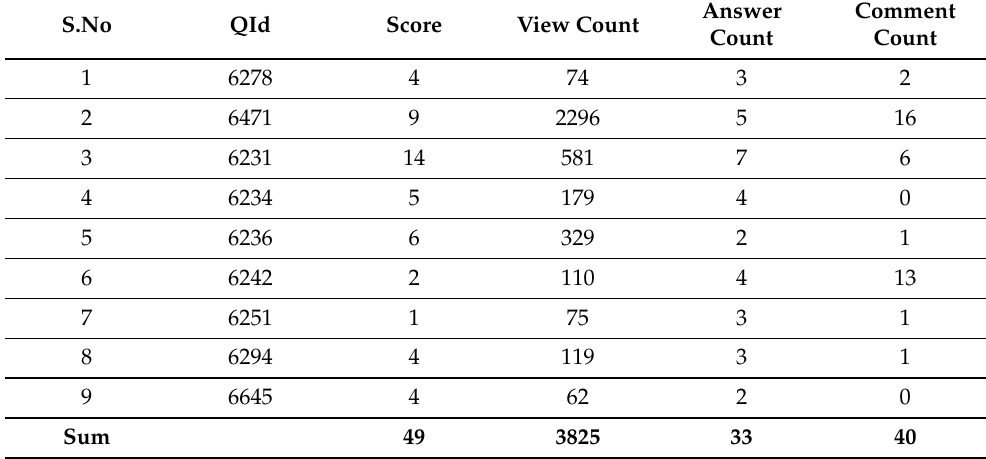
Table 1. Statistical information about the questions analyzed: QId: question ID; score: number of upvotes a question received; answer count: number of answers a question received; comment count: number of comments a question received.